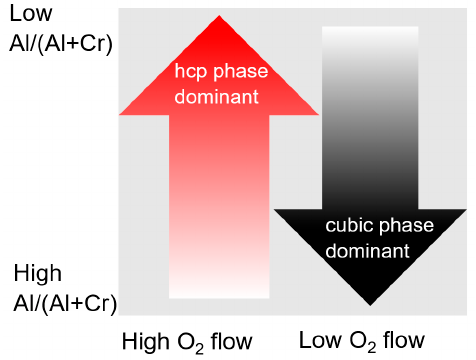
Figure 25. Schematic representation of the influence the coating composition has on the trend of phase formation in (AlCr) 2 O 3 , redrawn after [166], original © Elsevier. A low level of O and a high Al content (e.g., using cathodes of Al 66 Cr 34 ) in the coatings results in the formation of cubic (Cr,Al) 2 O 3 layers. Higher levels of O and Cr (e.g., using cathodes of Cr 75 Al 25 ) in the coatings increase the probability of the deposition of α (Cr,Al) 2 O 3